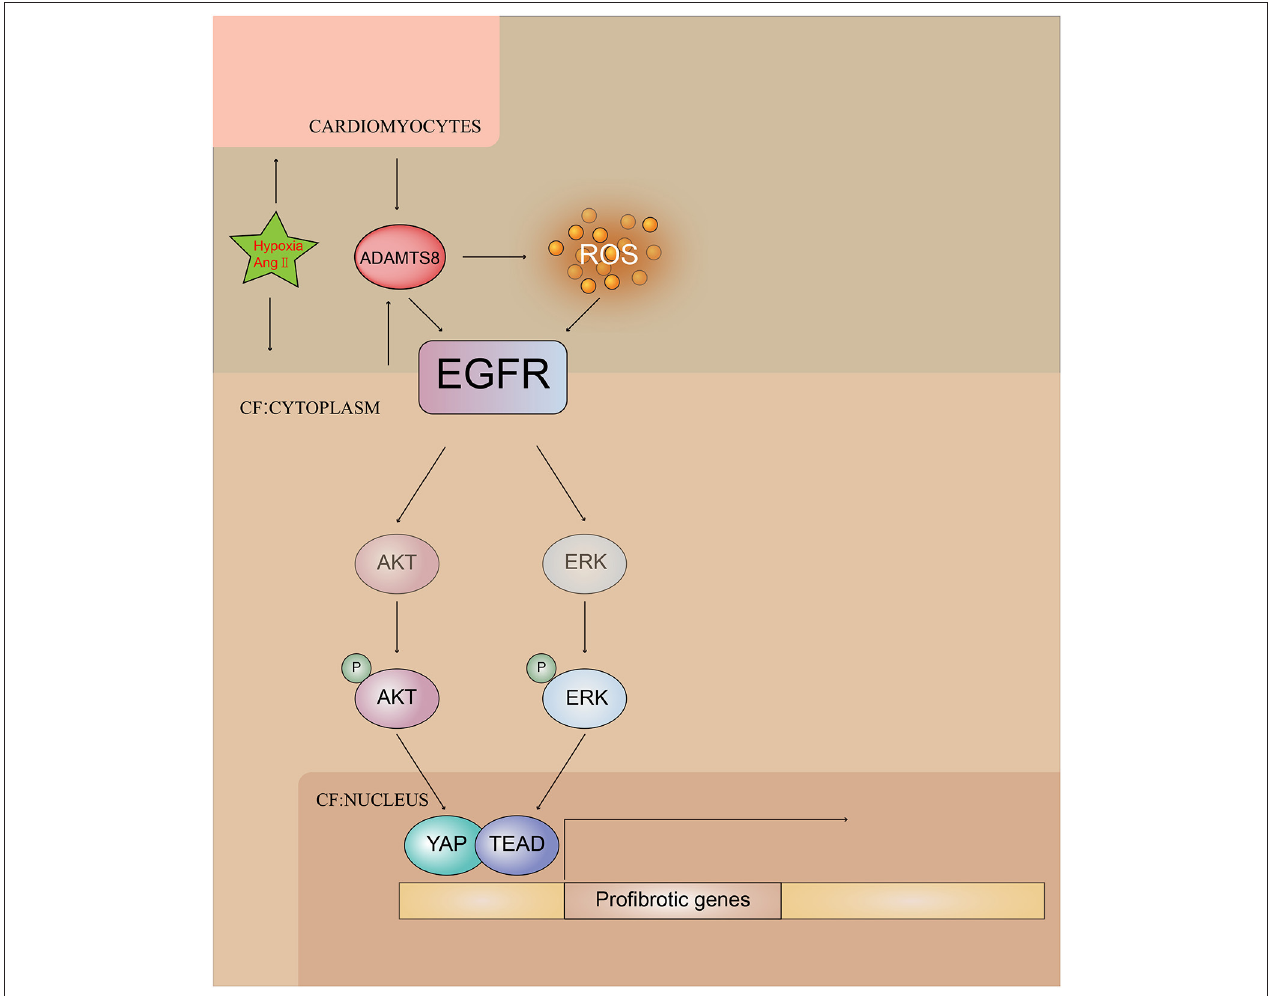
FIGURE 10 | Illustrating ADAMTS8-mediated activation of EGFR signaling pathway by hypoxia and Ang-II stimulation.